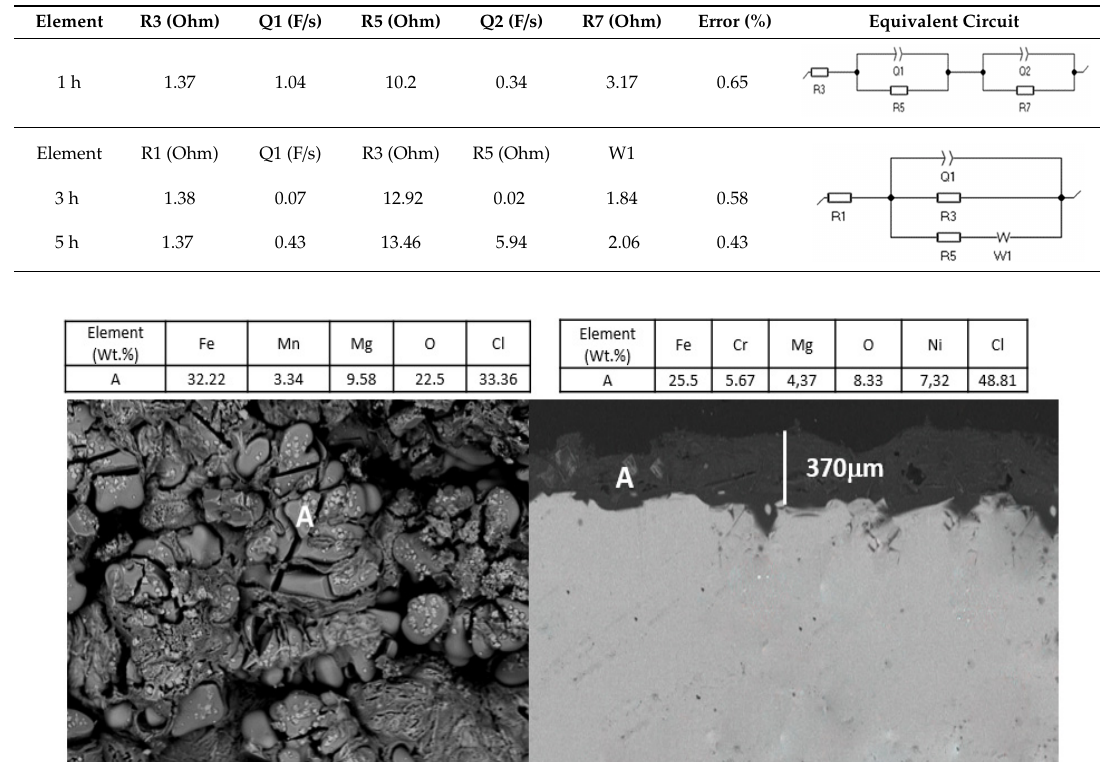
Figure 5. Nyquist diagram of OCI immersed in ternary chloride molten salt for 1, 3, and 5 h. Table 4. Electrochemical parameters obtained from EIS tests of OCI alloy. Table 5. Electrochemical parameters obtained from EIS tests of OCT alloy.